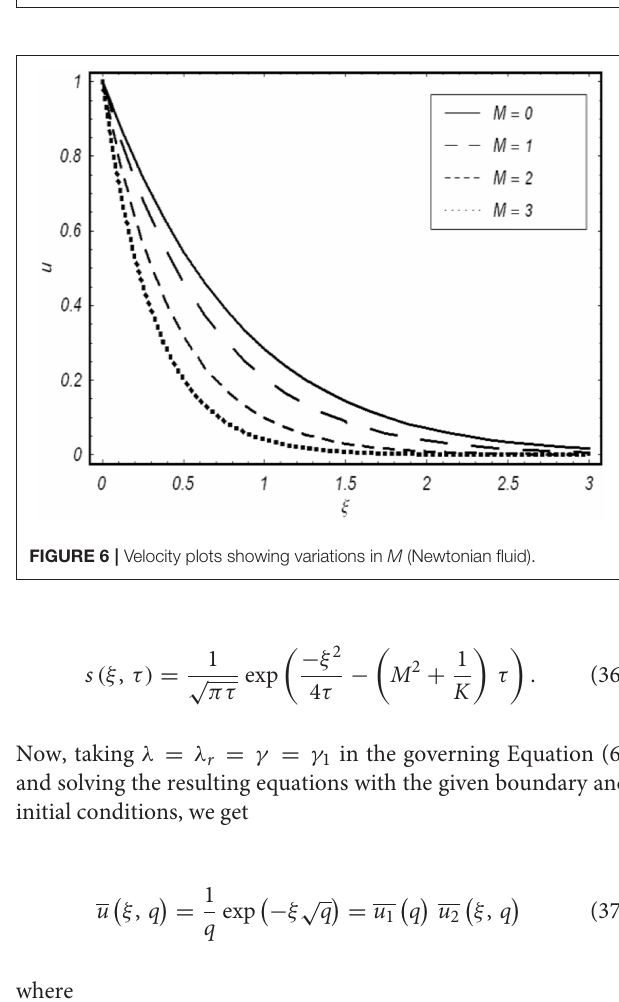
FIGURE 5 | Velocity plots showing variations in K (Newtonian fluid).